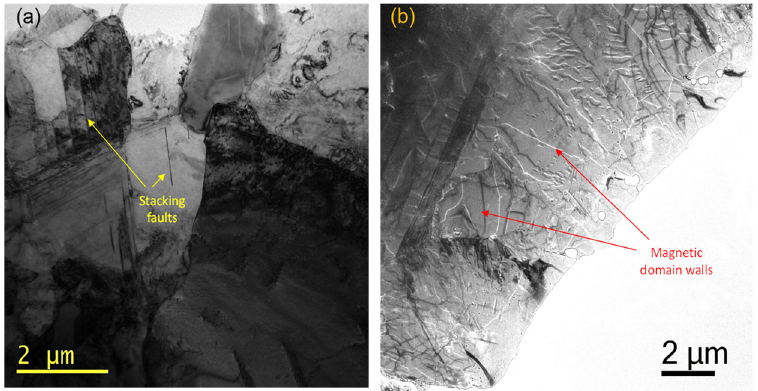
Figure 5. TEM characterization for τ -Sample-C ( a ) TEM image at intermediate magnification and ( b ) magnetic image by Lorentz microscopy. ( b ) magnetic image by Lorentz